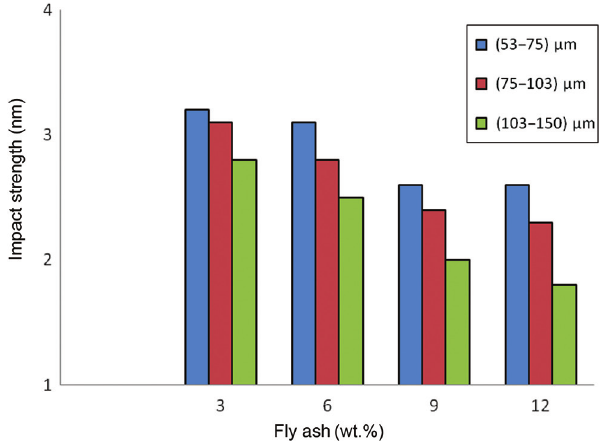
Figure 7 Influence of fly ash percentage and particle size on impact